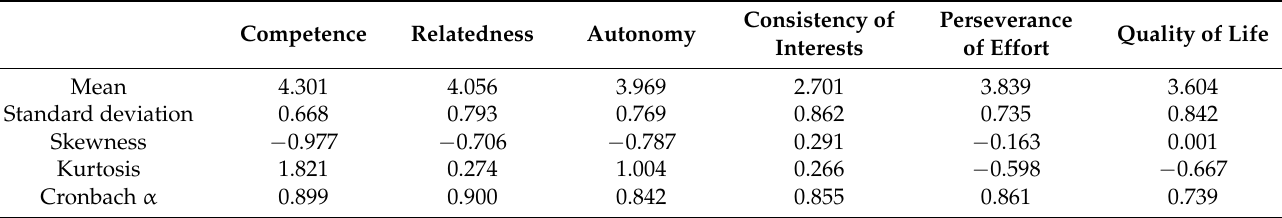
Table 2. The results of normality and reliability analyses.